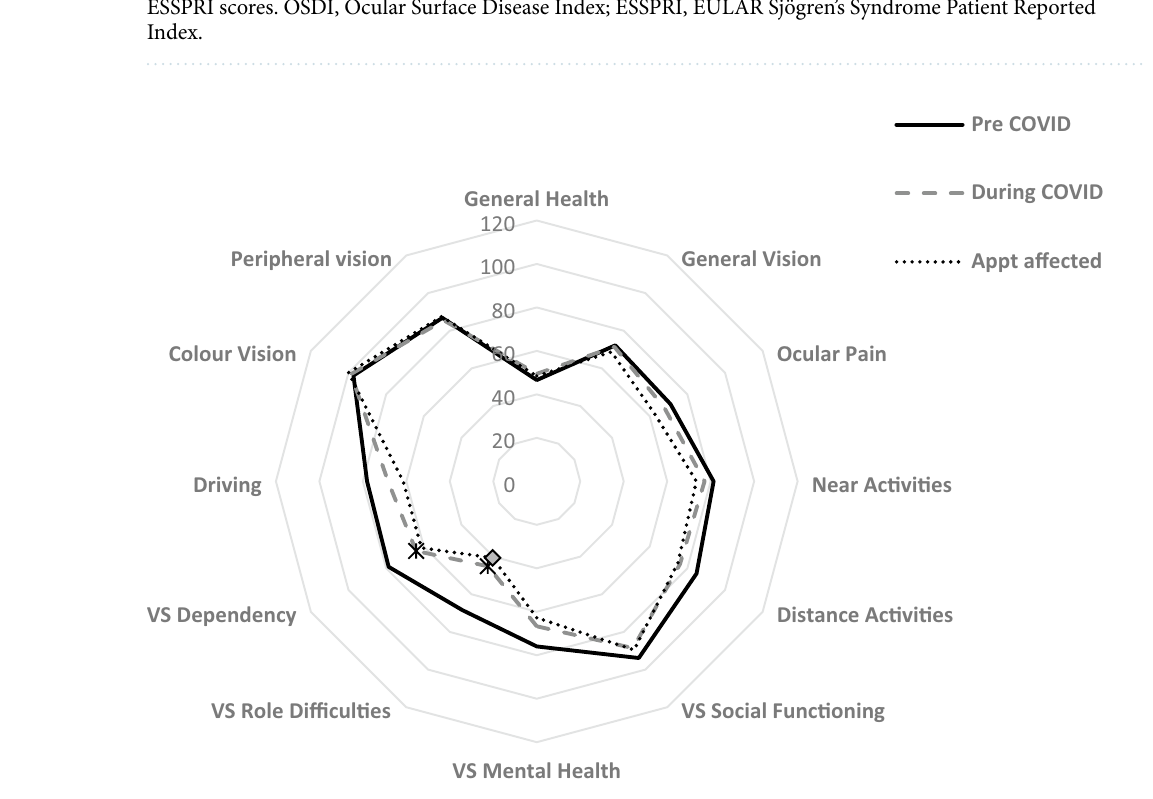
Figure 2. Radar chart comparing the NEI VF-25 results of pre COVID-19 and during COVID-19 NEI VF-25 results (Wilcoxon test) and participants whose outpatient appointments with ophthalmology were affected by the COVID-19 related lockdown (Mann–Whitney test). VS, vision specific, *p < 0.01, ◊p <